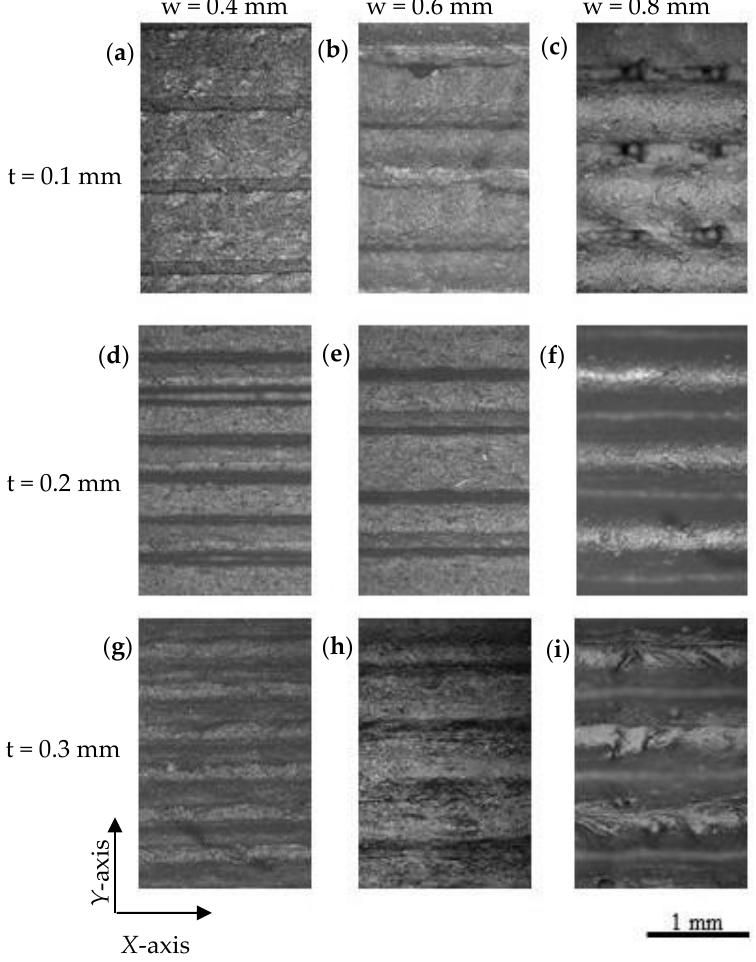
Figure 5. Optical micrographs of the surface of 3D printed parts: ( a ) P1.4, ( b ) P1.6, ( c ) P1.8, ( d ) P2.4, ( e ) P2.6, ( f ) P2.8, ( g ) P3.4, ( h ) P3.6 and ( i ) P3.8 (t = layer thickness, w = extrusion width).